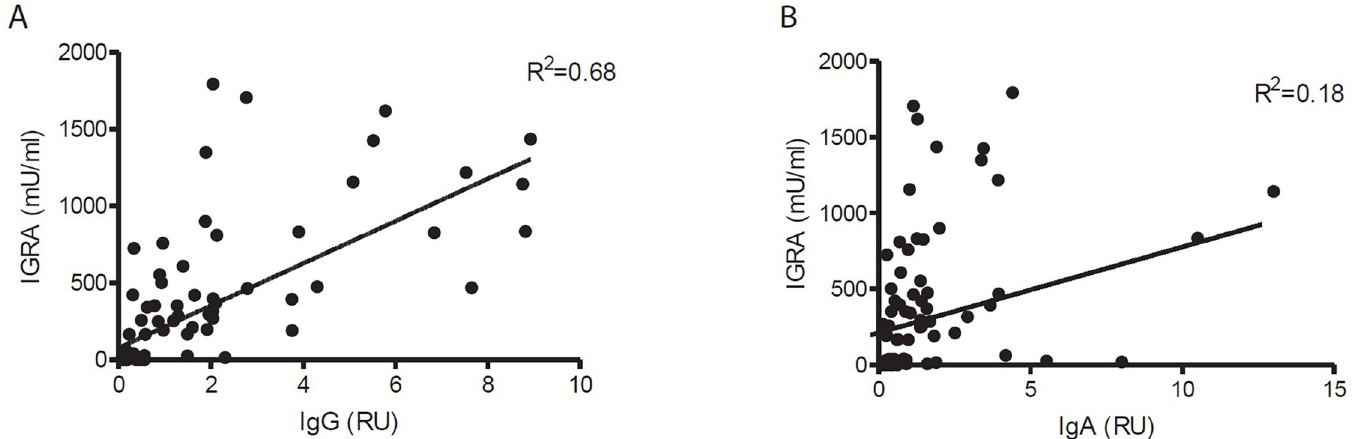
Fig 3. Correlation of immunoglobulin titers with IGRA response. Plot of interferon release as a function of IgG (A) and IgA (B) titers derived from serum taken in February 2021.